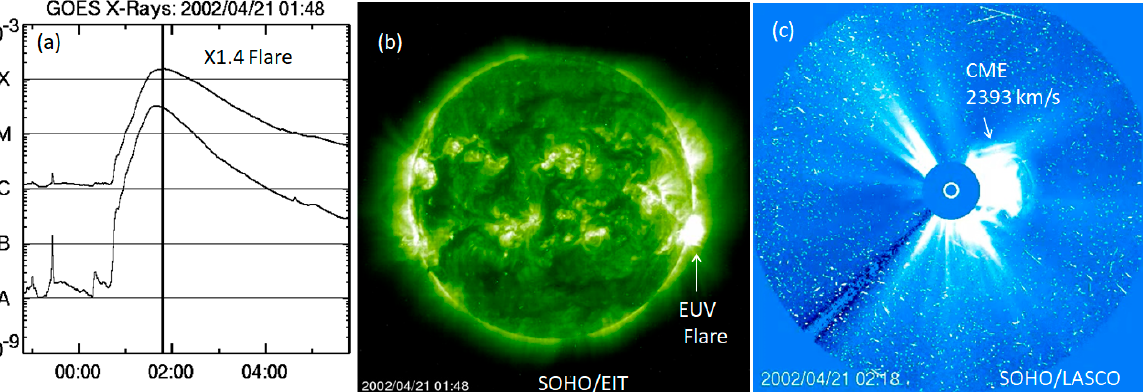
Figure 16. The 2002 April 21 eruption: ( a ) GOES soft X-ray flare, ( b ) the flare imaged by SOHO/EIT, and ( c ) the CME imaged by SOHO/LSACO. The dots and streaks in the CME image are due to energetic particles from the CME impacting the SOHO/LASCO detector and are referred to as a “snowstorm”.